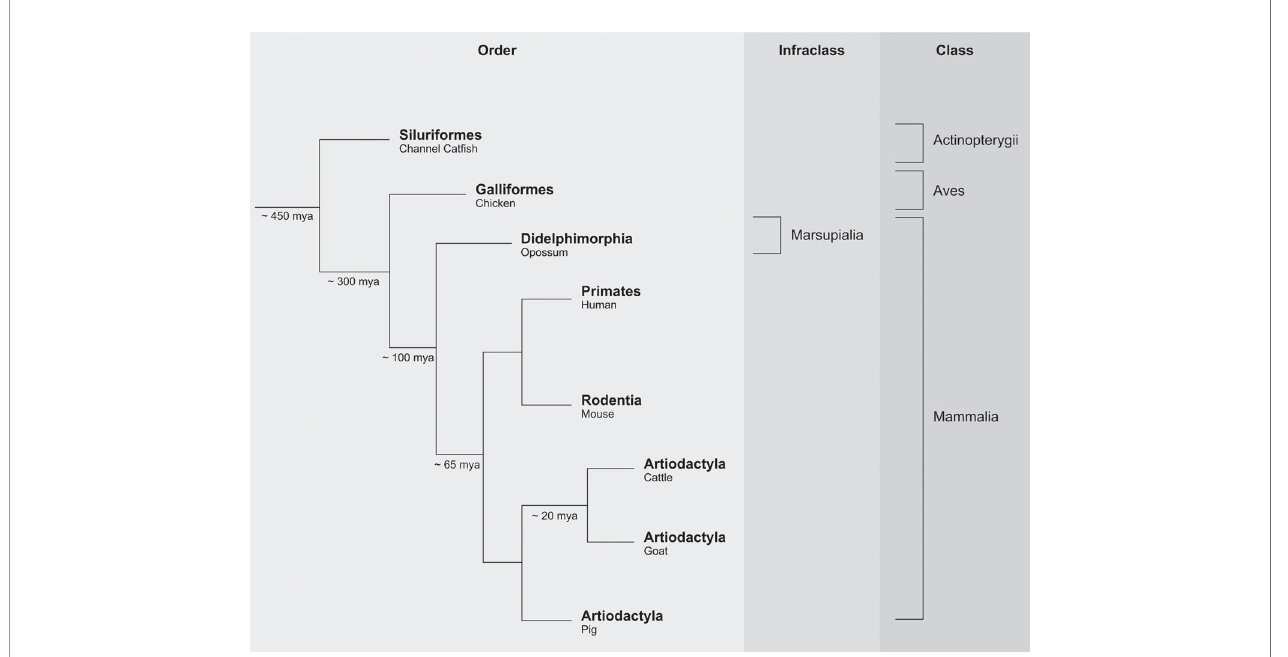
FIGURE 2 | Simpli fi ed phylogenetic scheme of vertebrate